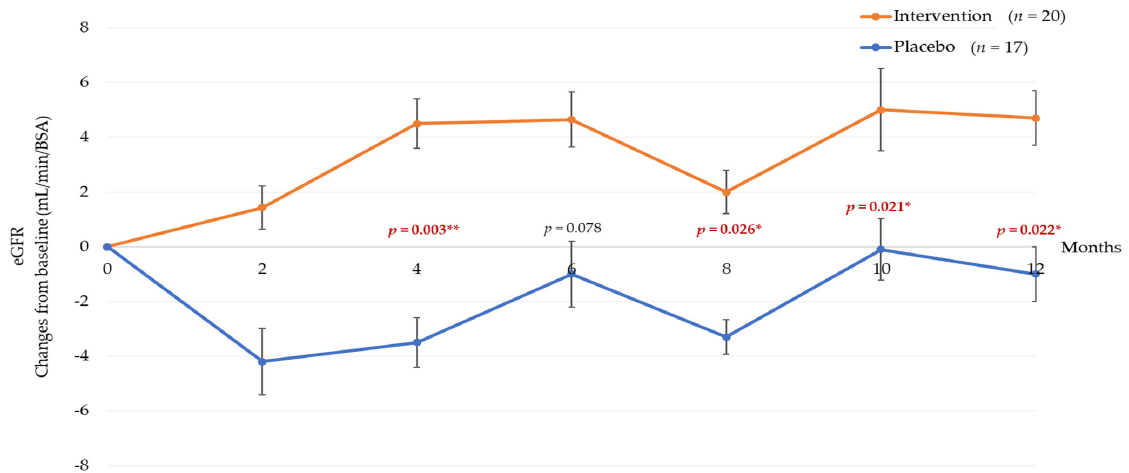
Figure 2. Graph of overall trend of estimated glomerular filtration rate (eGFR) for 12 months. Data are presented as mean ± standard deviation. * Significant at p < 0.05, ** p < 0.001.